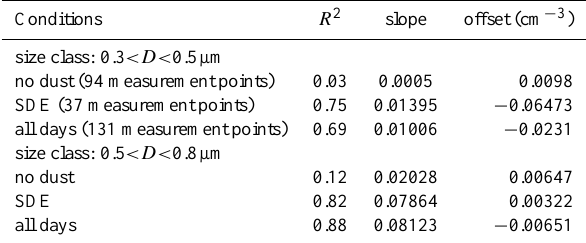
Table 3. Linear regression correlation coefficient R 2 , slope